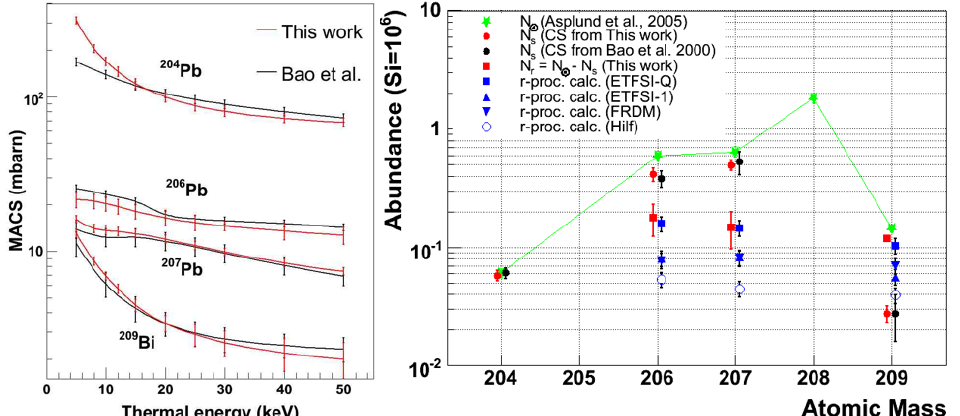
Figure 6. Maxwellian-averaged neutron capture cross sections for the 204,206,207 Pb and 209 Bi isotopes measured at CERN’s n_TOF (left panel). Solar system abundance analysis, with a disentanglement of the r -process component from the accurate s -process abundances (right panel). Furthermore, a comparison versus different r -process model calculations is shown, ruling out several of